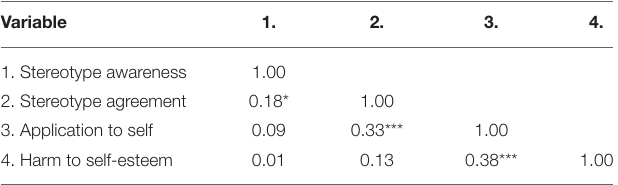
TABLE 3 | Pearson’s r bivariate correlation matrix for SSMIS-SF